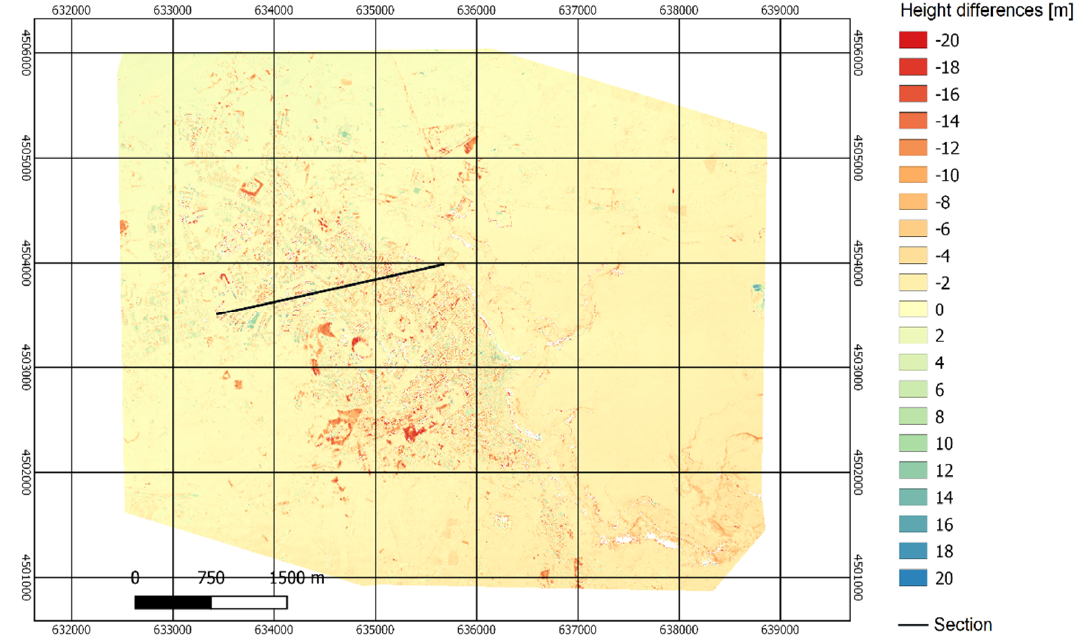
Figure 8. Error map (CRS: EPSG:32633-WGS 84/UTM, zone 33N-Projected) showing height differences (in m) between the